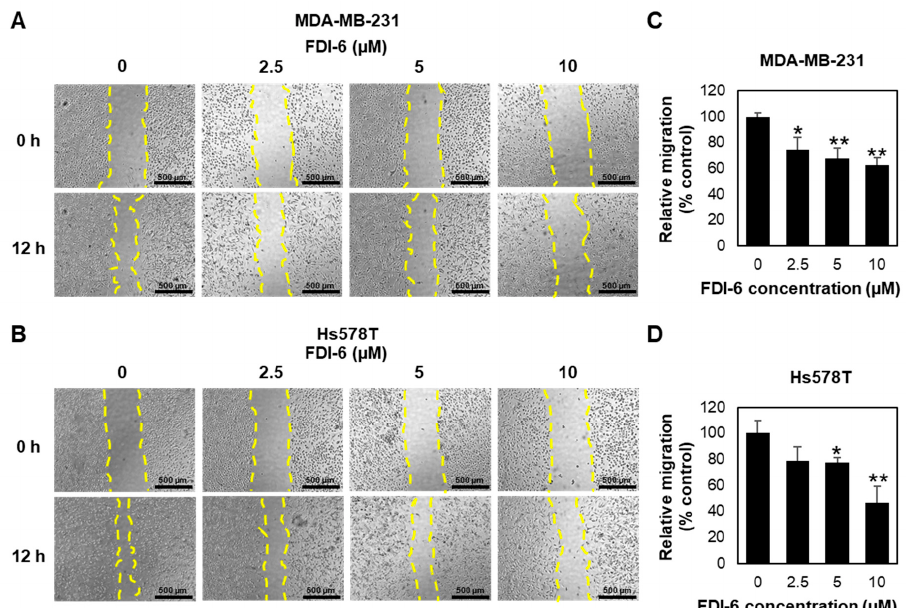
Figure 3. FDI-6 inhibited the migration of breast cancer cells. ( A , B ) Representative images of the wound healing assay of ( A ) MDA-MB-231 and ( B ) Hs578T cells after 12 h of FDI-6 treatment at indicated concentrations; ( C , D ) The bar graphs represent the average of relative migration of ( C ) MDA-MB-231 cells and ( D ) Hs578T cells in comparison with the control from three independent experiments ± S.D. ( n = 3). Statistical significance was determined by Student’s t-test (significant, * p < 0.05 and ** p < 0.01).